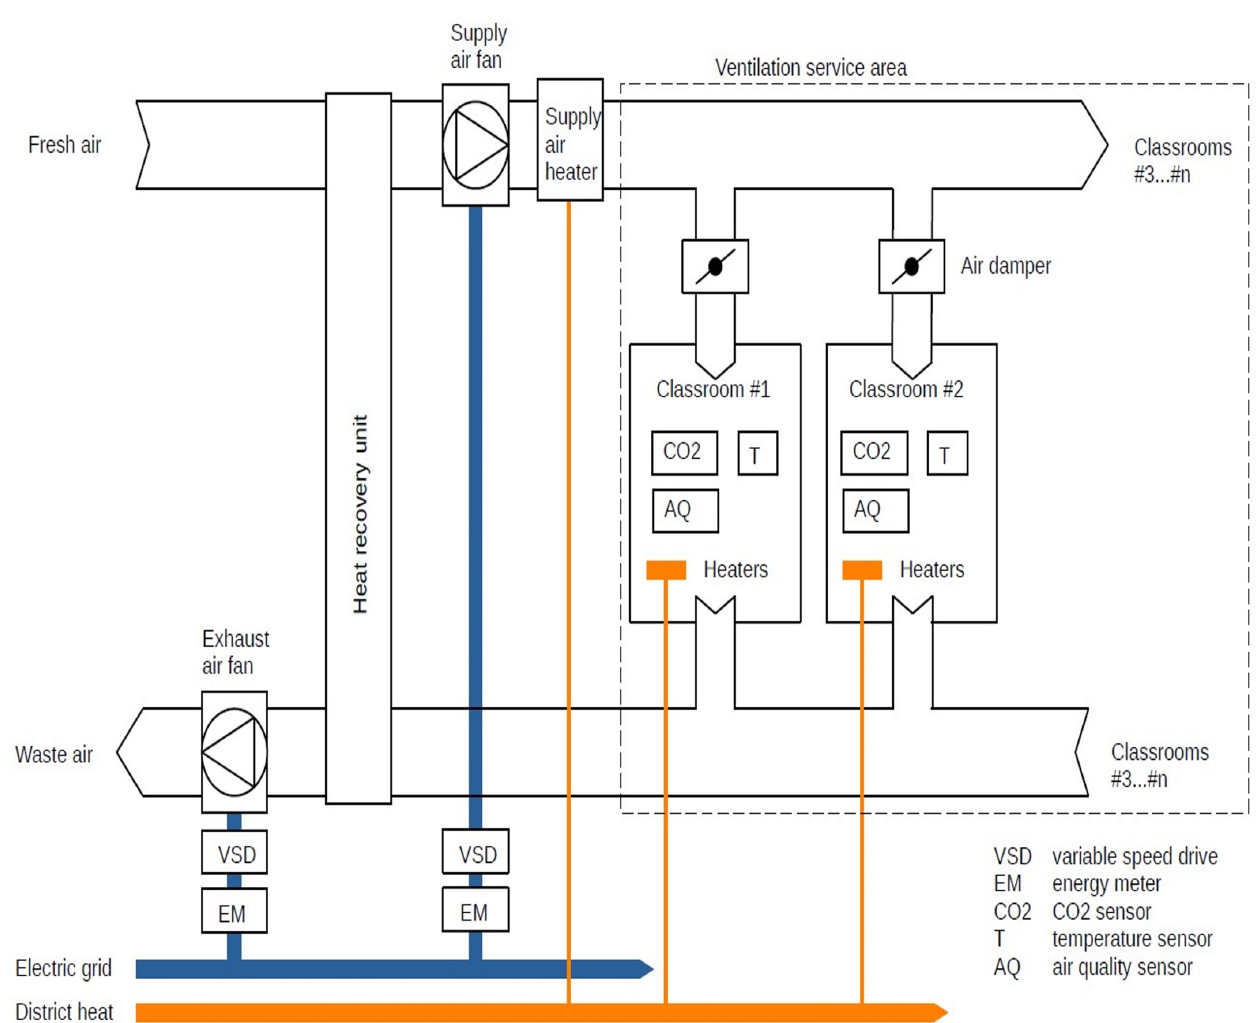
Figure 2. A simplified schematic of a ventilation system of an educational